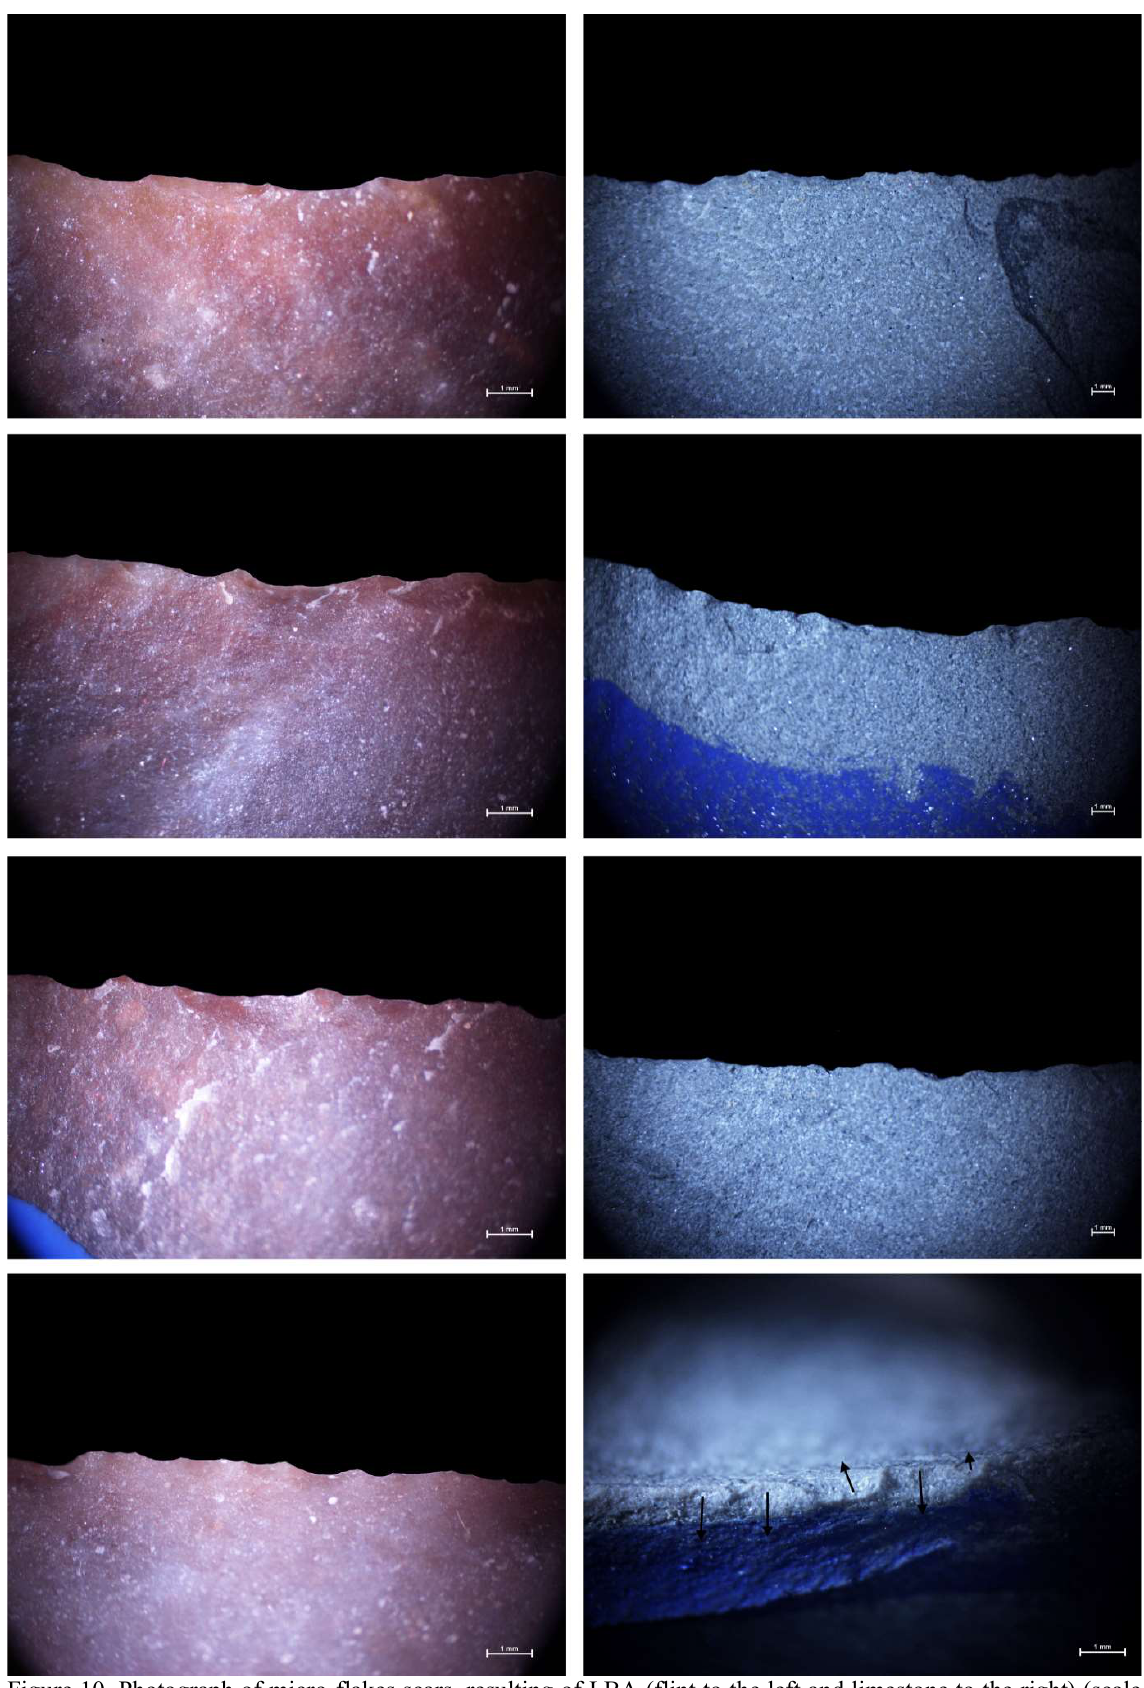
Figure 10. Photograph of micro-flakes scars, resulting of LBA (flint to the left and limestone to the right) (scale bar = 1